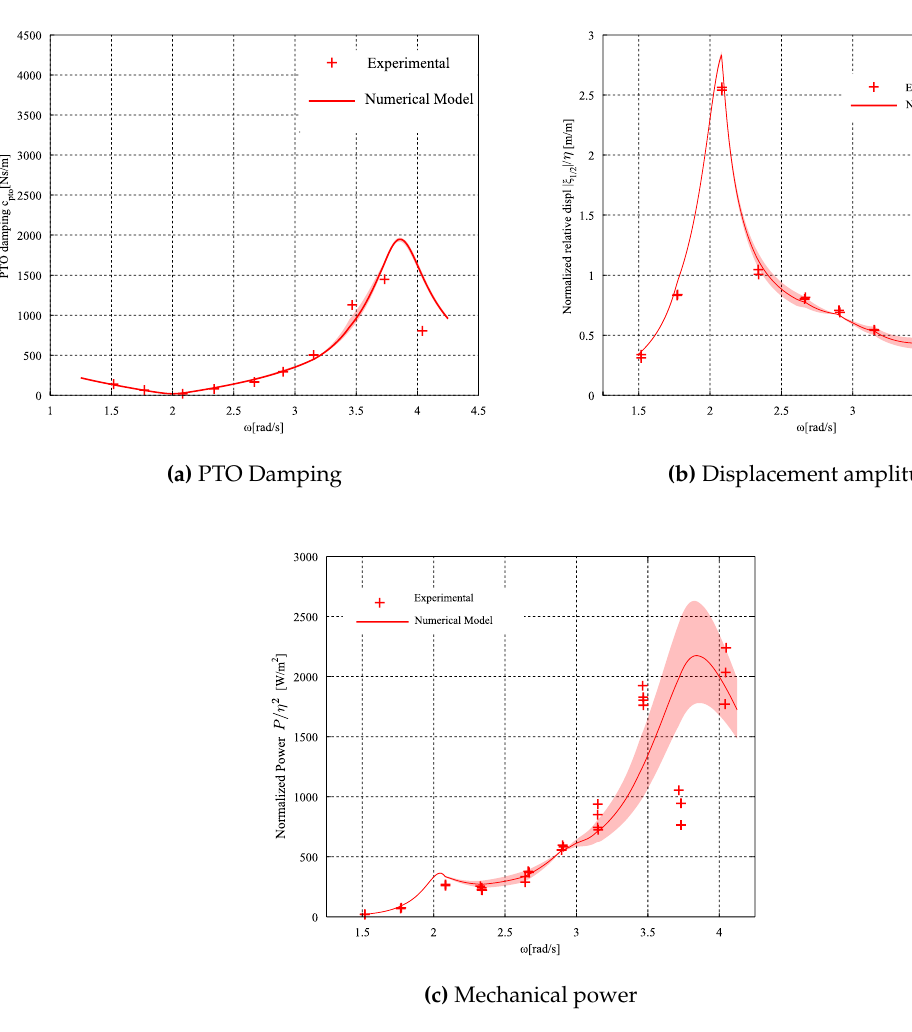
Figure 4. Two-body point absorber ( a ) optimal and experimentally applied c pto ; ( b ) displacement amplitudes; and ( c ) mechanical power in regular